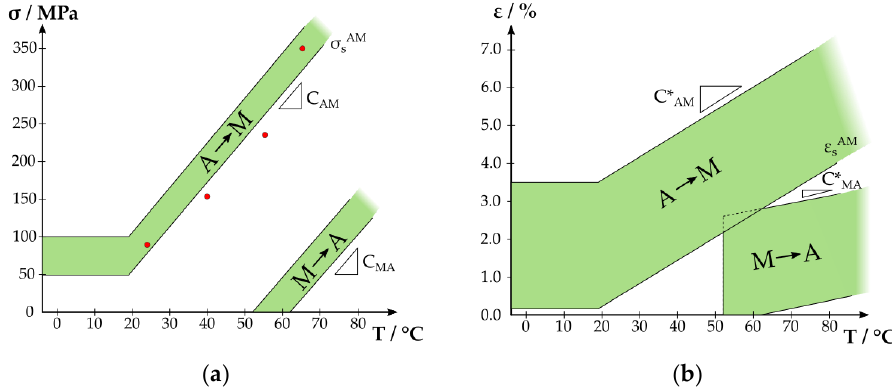
Figure 3. ( a ) Classical phase diagram obtained from experimental values (red dots); ( b ) conversion into modified phase diagram as adapted from